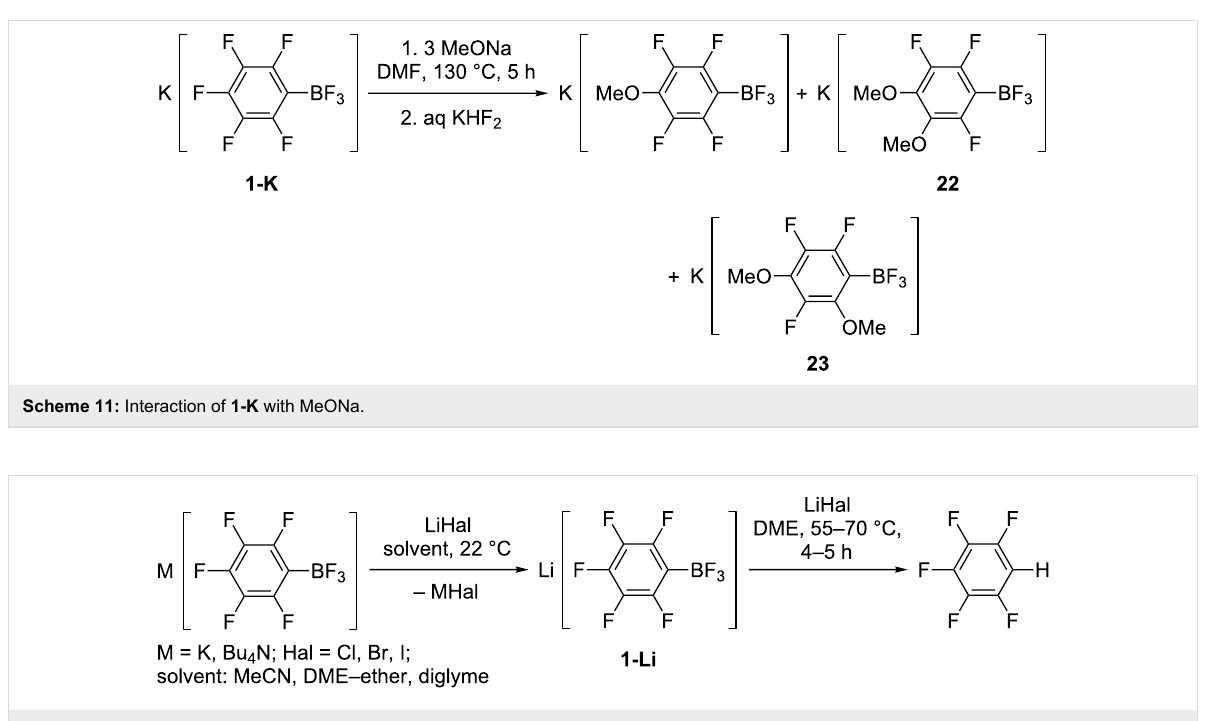
Scheme 12: Interaction of M[RC 6 F 5 BF 3 ] with lithium halides.